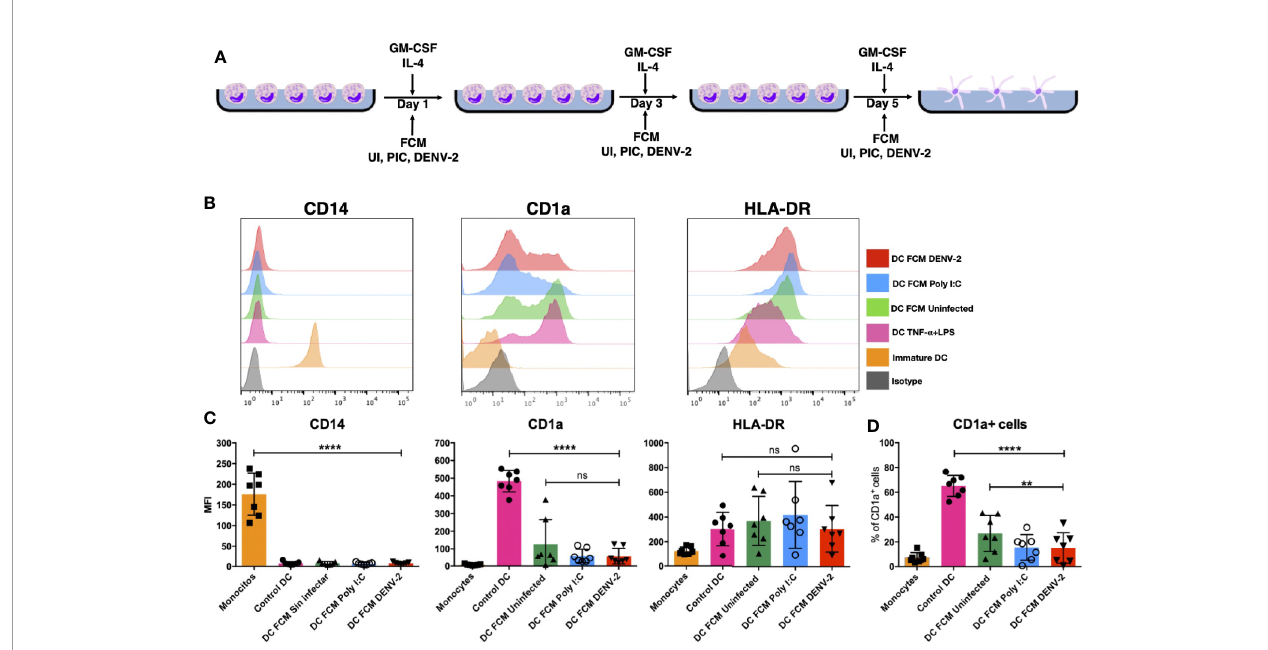
FIGURE 5 | Fibroblasts suppress monocyte differentiation into dendritic cells. Fibroblast conditioned media was used to treat monocytes for 6 days in the presence of GM-CSF and IL-4, then CD14, CD1a, and HLA-DR expression levels were evaluated using fl ow cytometry. (A) Schematic representation of experimental conditions. (B) Representative histograms of moDCs from one donor showing the expression of CD14, CD1a, and HLA-DR under the treatments previously mentioned. (C) Graphic representation of MFI of cells expressing CD14,CD1a and HLA-DR on the moDC after differentiation. (D) Analysis of the percent of cells expressing CD1a on moDC. Error bars indicate the standard deviations for the three independent experiments of each donor; n = 7. ns, no signi fi cant. **P < 0.01 and ***P <